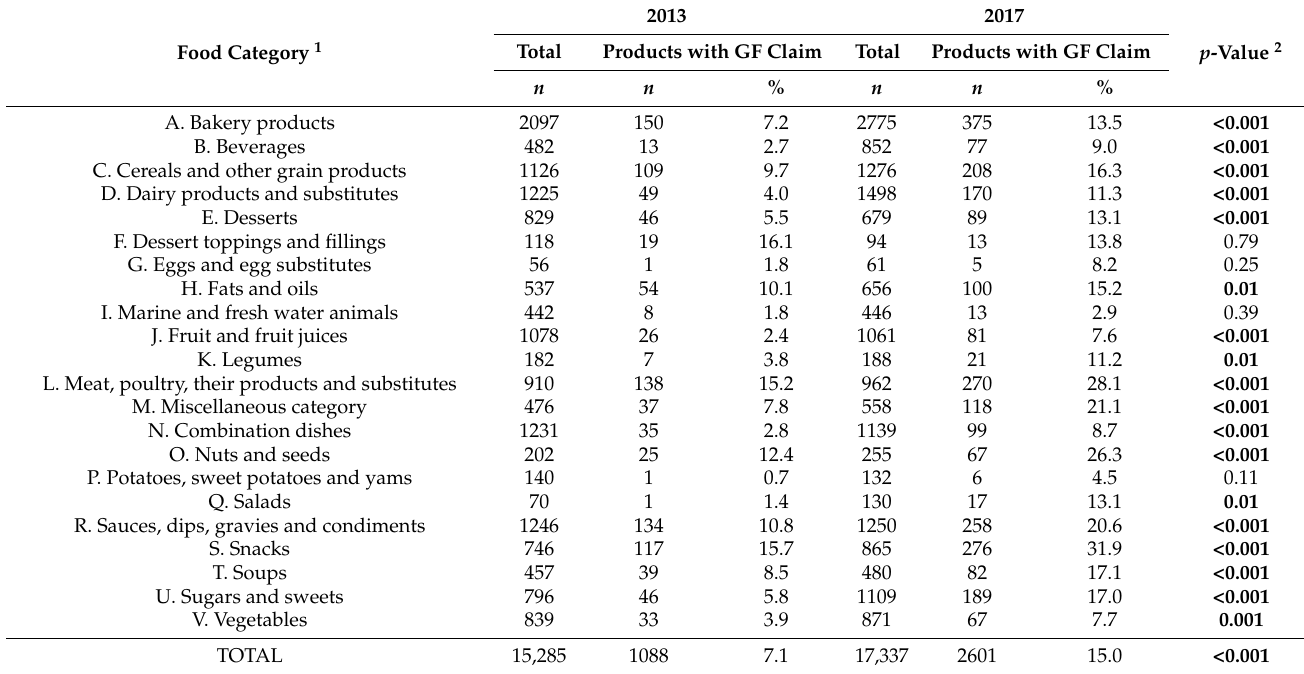
Table 1. The number and proportion of Canadian packaged foods and beverages with gluten-free (GF) claims in 2013 and 2017.